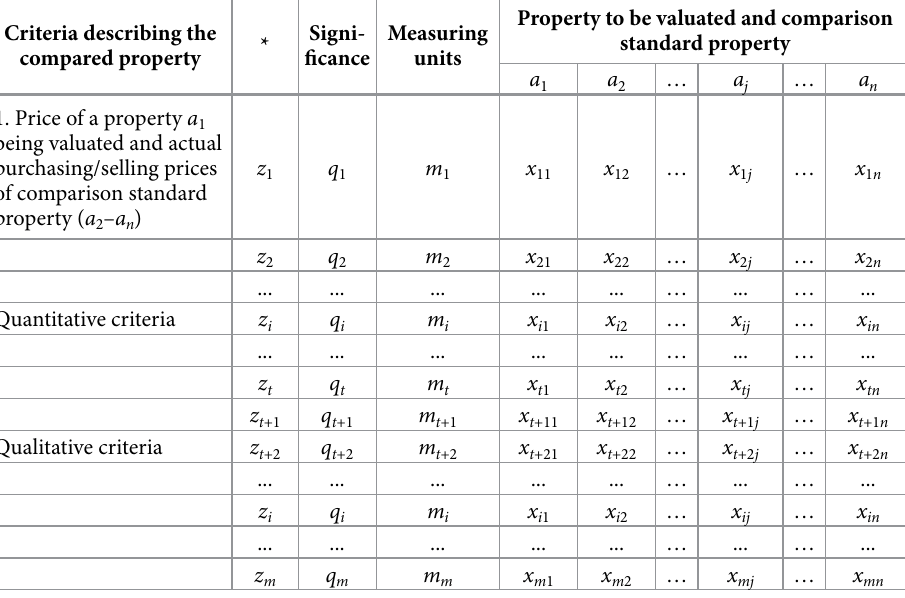
property to be valuated and comparison signi­ measuring standard property * ficance units a 1 a 2 … a j a